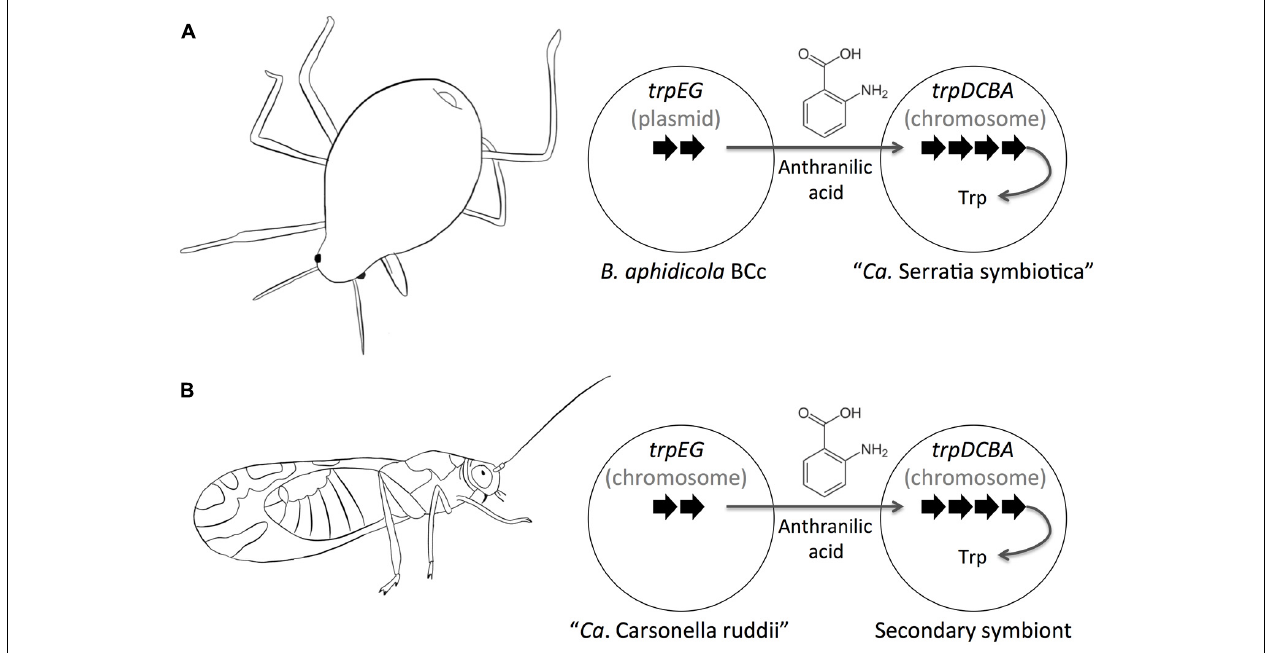
FIGURE 5 | Convergent evolution ofTrp biosynthesis. The biosynthesis ofTrp is performed cooperatively by two different endosymbionts in the aphid Cinara cedri (A) and in the psyllid Heteropsylla cubana (B) . Strikingly, the same division of labor evolved in both systems.